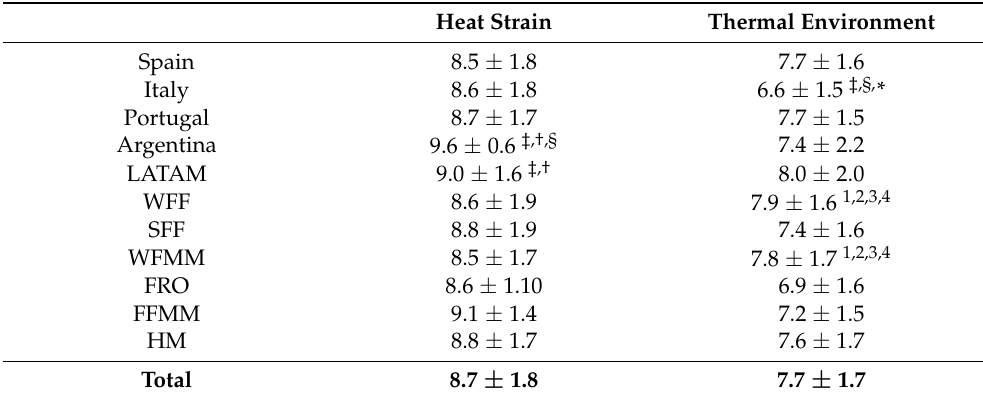
Table 2. Importance given as risks factors to heat strain and the thermal environment during wildland fire suppression by country and job position. Values expressed as mean ±